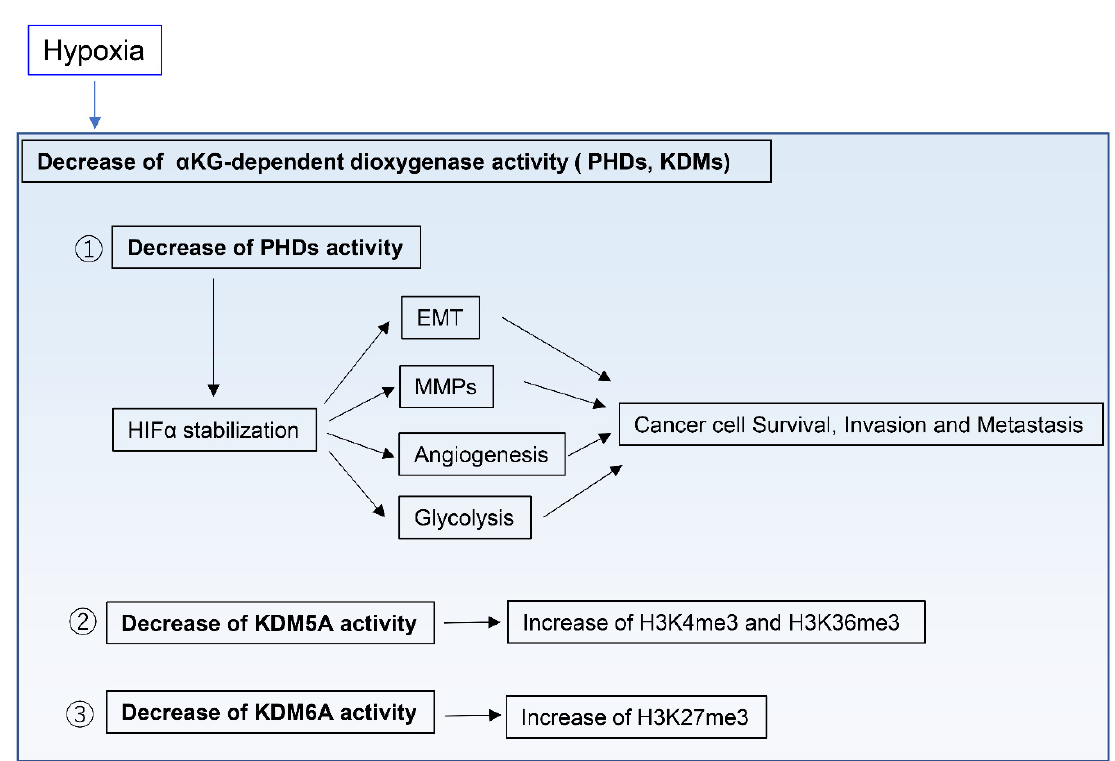
Figure 3. Adaptation to hypoxic tumor microenvironments. Hypoxia decreases α KG-dependent dioxygenase activity such as prolyl hydroxylases (PHDs) and histone lysine demethylases (KDMs), which affect cancer cell property and histone H3 methylation status. HIF; hypoxia-inducible factor, EMT; epithelial-to-mesenchymal transition, MMPs; Matrix metalloproteinases.